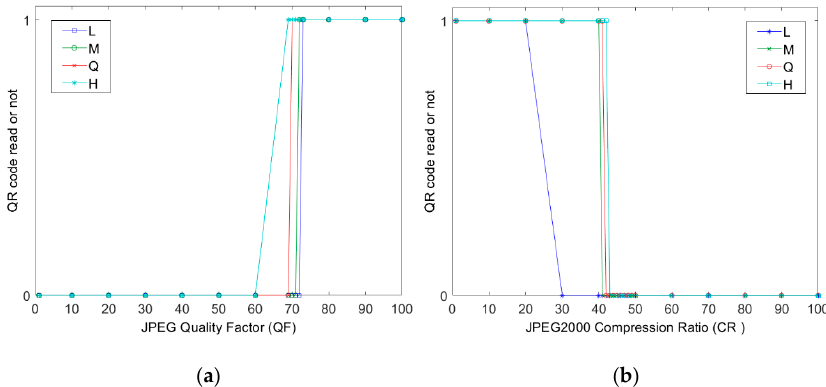
Figure 18. Ability to read and decode the information of the exhibited QR code against: ( a ) JPEG and ( b ) JPEG2000.